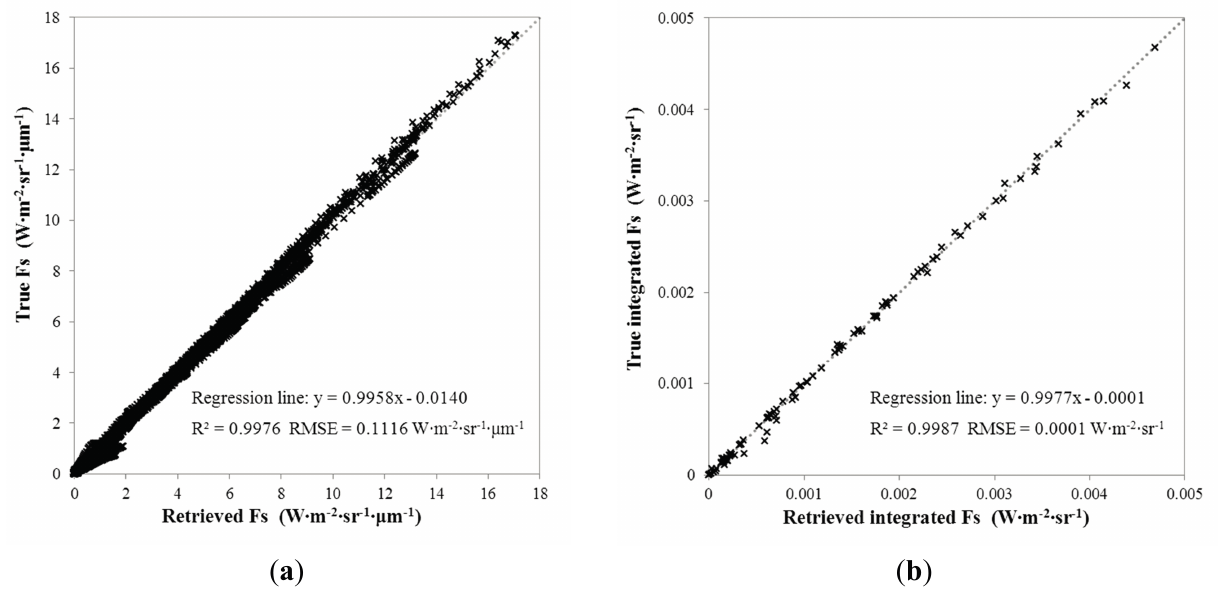
Figure 5. ( a ) Scatter diagram of retrieved versus “true” Fs values at all wavelengths within the Fs emission region from 640–850 nm with 1 nm step. ( b ) Scatter diagram of retrieved versus “true” Fs integrated over the Fs emission region from 640–850